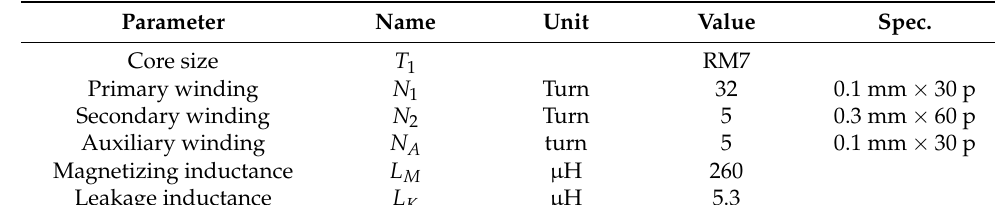
Table 3. Transformer characteristics of experimental AC – DC adapters.